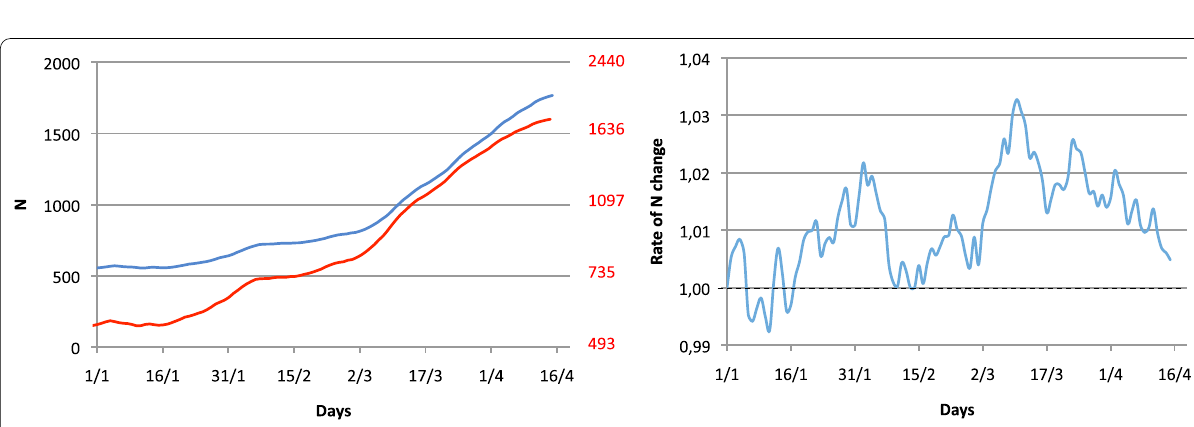
Fig. 2 Evolution of the number of COVID-19 patients requiring intensive care (7 days moving average) in the Paris area. On the left panel, N is plotted in the y-axis with standard scale (blue curve) or log scale (red curve). On the right panel, the daily rate of N change is plotted on the